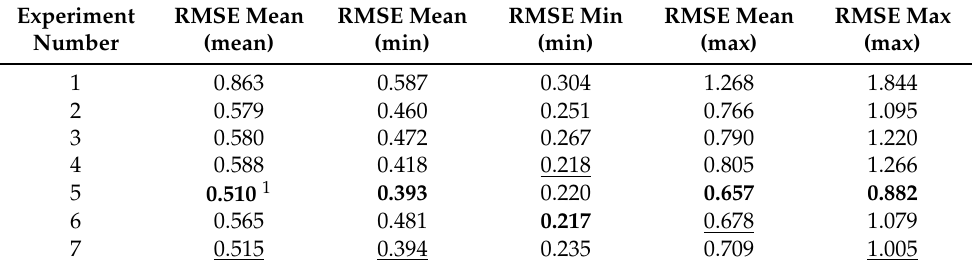
Table 6. Obtained results of each experiment number in mmol/L.